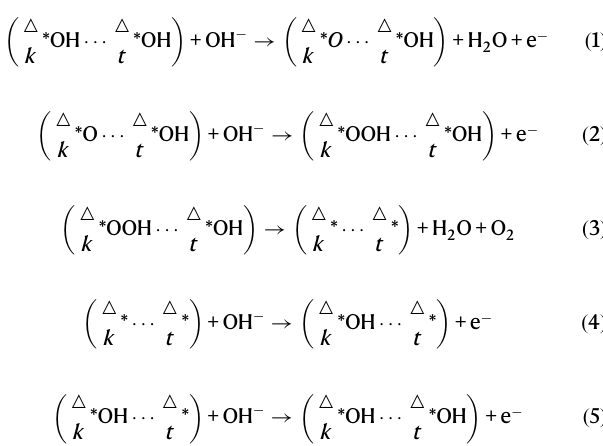
OER is highlighted in green. b The active structural motif of mono- µ -oxo-bridged Co in a tetrahedral geometry. c – e The key intermediate stepsinthe proposedOER